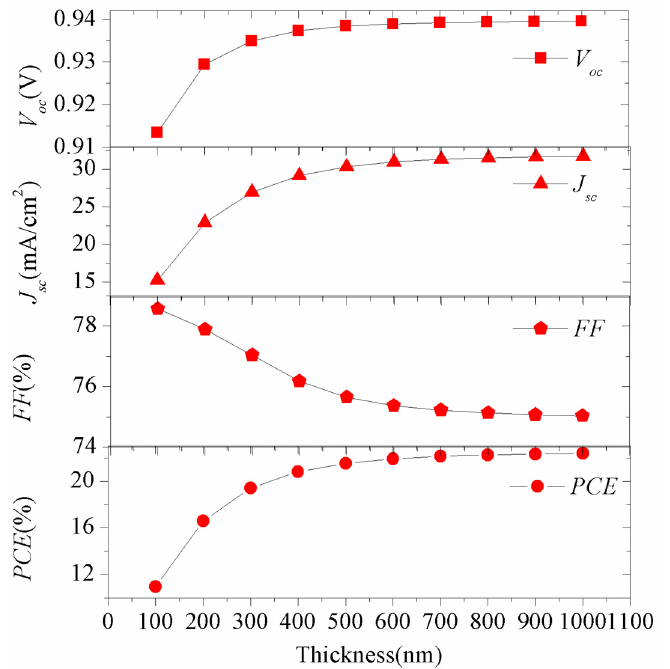
Figure 8. E ff ect of absorber layer thickness on solar cell Figure 8. Effect of absorber layer thickness on solar cell performance.